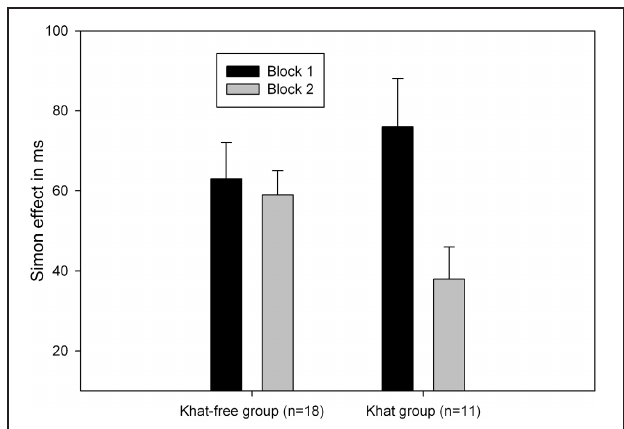
FIGURE 1 | Mean Simon effect (calculated as the RT difference between non-correspondent and correspondent trials) as a function of block (1 vs. 2) and group (khat users vs. khat-free controls). Standard errors of the difference between non-correspondent trials and correspondent trials are represented by the error